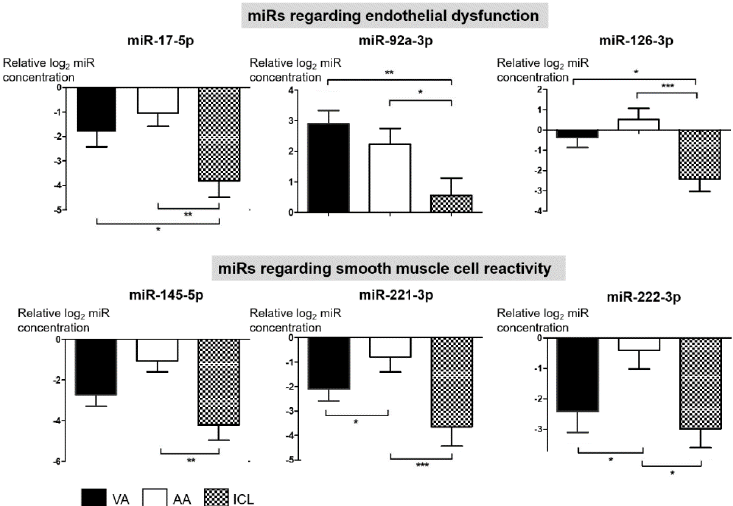
Figure 2. Circulating miR profiles according to coronary artery disease category. The miR expression relative to mean of the control miR, c-elegans-39 (miR-39) in the VA group ( n = 46), AA group ( n = 49), and ICL group ( n = 26) is demonstrated. Y -axis scale is log-transformed. AA, atherothrombotic angina; Ct, cycle threshold; ICL, insignificant coronary lesion; miR, microRNA; VA, vasospastic angina. One-way analysis of variance was applied and data are presented as mean ± standard deviation. * indicates p < 0.05, ** indicates p < 0.01, *** indicates p < 0.001.